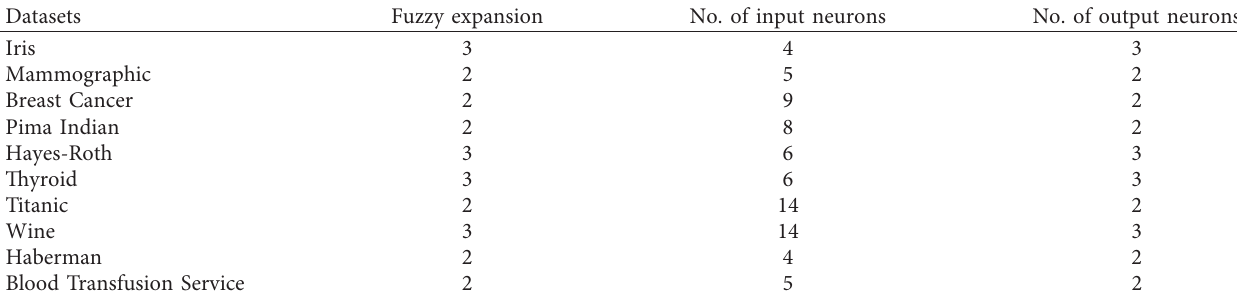
Table 5: Parameters of the models.